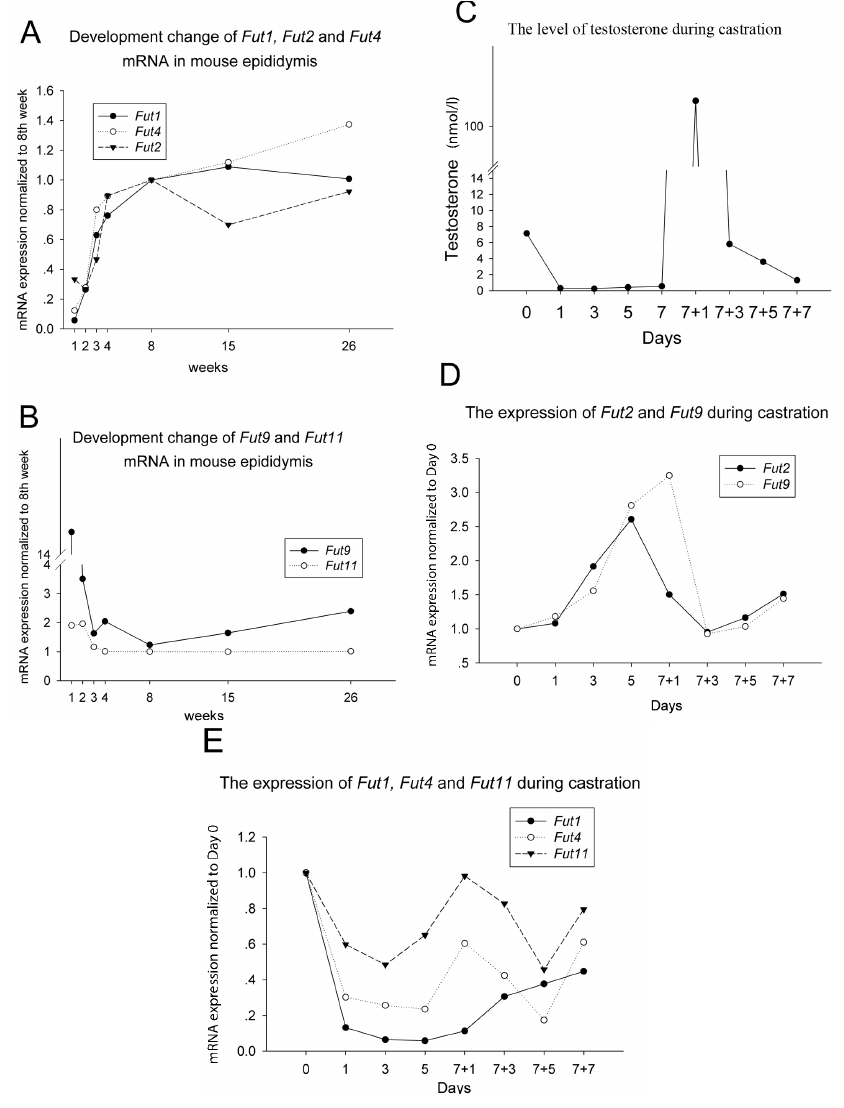
Figure 1. The mRNA expression of ( A ) Fut1 , Fut2 and Fut4 and ( B ) Fut9 and Fut11 during mouse development. X -axis: age, weeks after birth. Y -axis: mRNA expression quantified by real time PCR, normalized to the eight weeks; ( C ) The change of serum testosterone concentrations following castration and androgen replacement. The expression of ( D ) Fut2 and Fut9 mRNA and ( E ) Fut1 , Fut4 and Fut11 mRNA, following castration and androgen replacement. Three to five mice were used for each time point, and 3–5 pairs of epididymis were pooled together for RNA extract and RT-qPCR. qPCR for each sample were repeated at least three times. ‘//’ in the Y axis of ( B ) and ( C ) indicate a break to shrink the range of the